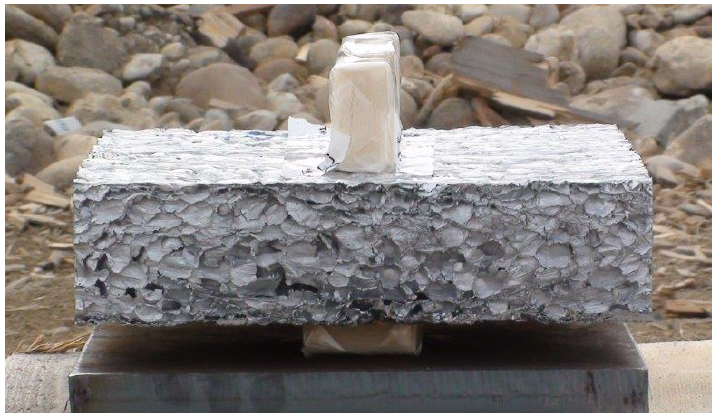
Figure 8. Crash absorbers ( a ) of the Combino tram in Budapest produced by Alulight; and ( b ) of the Sprinter Light Train in Holland produced by Gleich and SAS Bratislava (courtesy of Alulight, Gleich and SAS Bratislava).